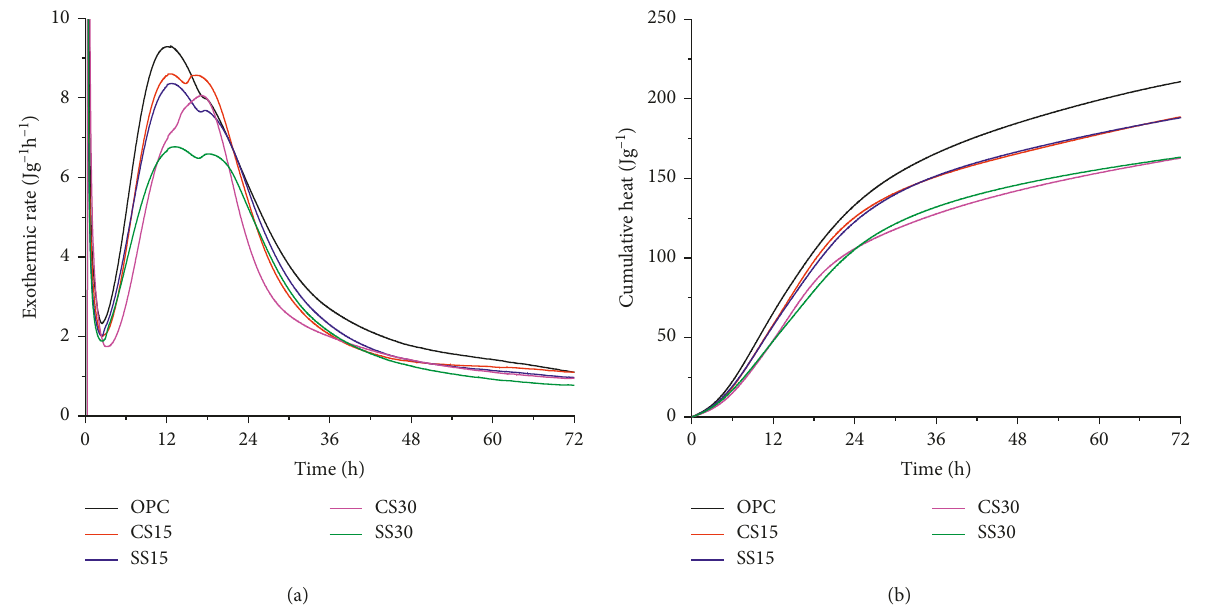
Figure 2: Hydration heat of different slag binders within 3 days: (a) exothermic rate and (b) cumulative hydration heat.